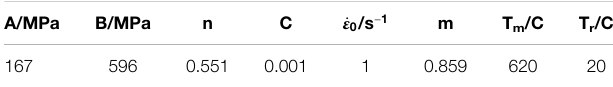
TABLE 2 | Parameters of Johnson-Cook constitutive equation for 5,083 aluminum alloy.